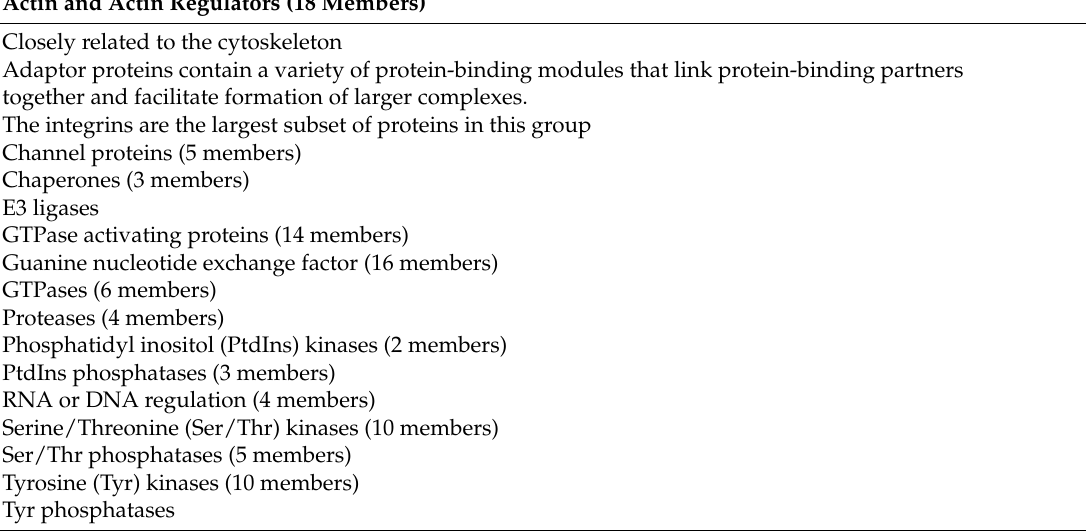
Table 2. The integrin